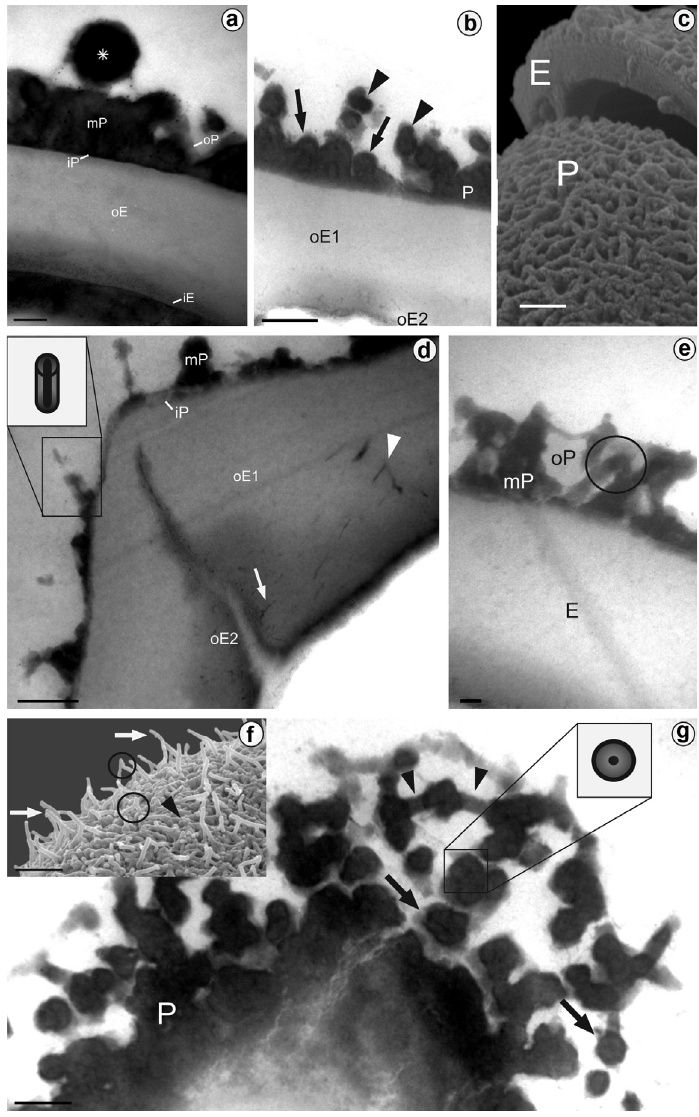
Figure 3 - Spores of Microlepia speluncae with TEM ( a-b , d-e , g ) and SEM ( c , f ). a. In this picture, the inner exospore (iE) is thin, with a homogeneous structure and low electron-density. Spheroids with the same ultrastructure and electron-density than perispore are observed (asterisk). Outer exospore (oE), inner perispore (iP), medium perispore (mP), outer perispore (oP). Scale bar shows short channels, fi ssures and cavities fi lled with an electron-dense = 0.4 μ m. b. Section through the sporoderm, where: (oE 2) material; and (oE is thicker than the inner one, with irregular outer margin and homogeneous structure. The perispore (P) is formed 1) of threads tangential (arrows) and perpendicular oriented (arrowheads). Scale bar = 0.4 μ m. c. Sporoderm fracture with SEM. The Perispore (P) threads cover the exospore (E). Scale bar = 1 μ m. d. Section through the lesurae. In the inner stratum fi ssures ). The outer stratum (oE ) is thicker than oE , with an and cavities fi lled with an electron-dense material (arrow) are present (oE 2 1 2 irregular margin, homogeneous structure, and has channels (arrowhead). The inner perispore (iP) is thin; the middle perispore (mP) has threads with a central core and peripheral area more electron-denser than middle area (scheme). Scale bar = 0.4 μ m. e. The medium layer (mP) forms a three-dimensional network of threads. The outer layer (oP), is discontinuous; low electron-dense and shows an homogeneous structure. Threads can be fused at the tip (circle). Exospore (E). Scale bar = 0.1 μ m. f . The threads of the ornamentation are fused and form a tangential network (arrowhead), with some perpendicular elements (arrows). The perpendicular threads could fuse at the top forming spinules (circles) Scale bar = 2 μ m. g. Section through the sporoderm at a spore corner. The threads (arrow) have a central core and a periphery more electron-denser than the medium area (scheme). Some threads are fused (arrowhead). Scale bar = 0.4 μ m. P =